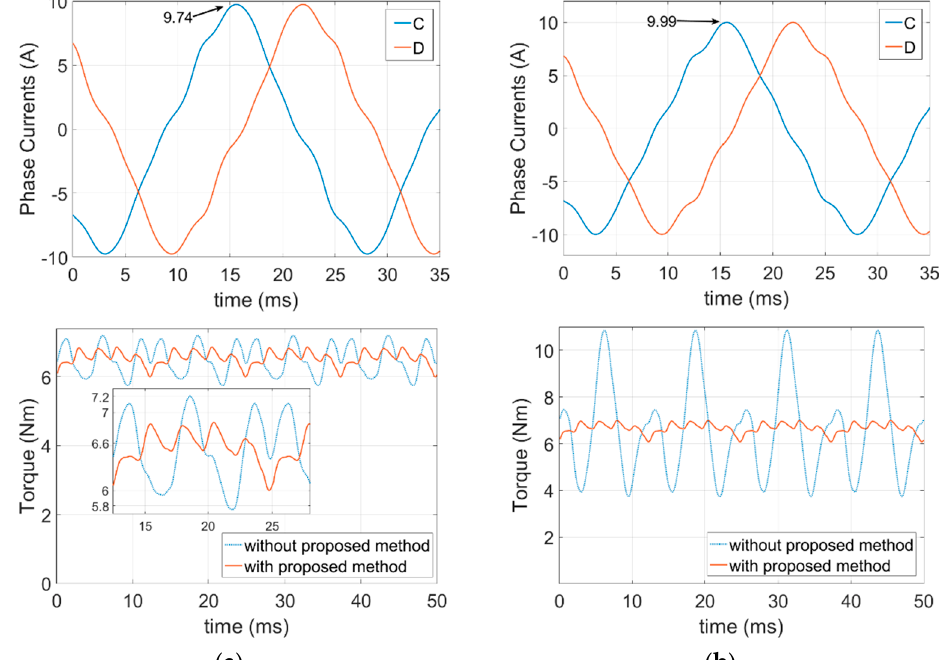
Figure 15. FEA torque waveforms for the fault-tolerant control currents of the ATPOC condition with and without the proposed method: ( a ) Only fundamental; ( b ) fundamental plus third har- monic.